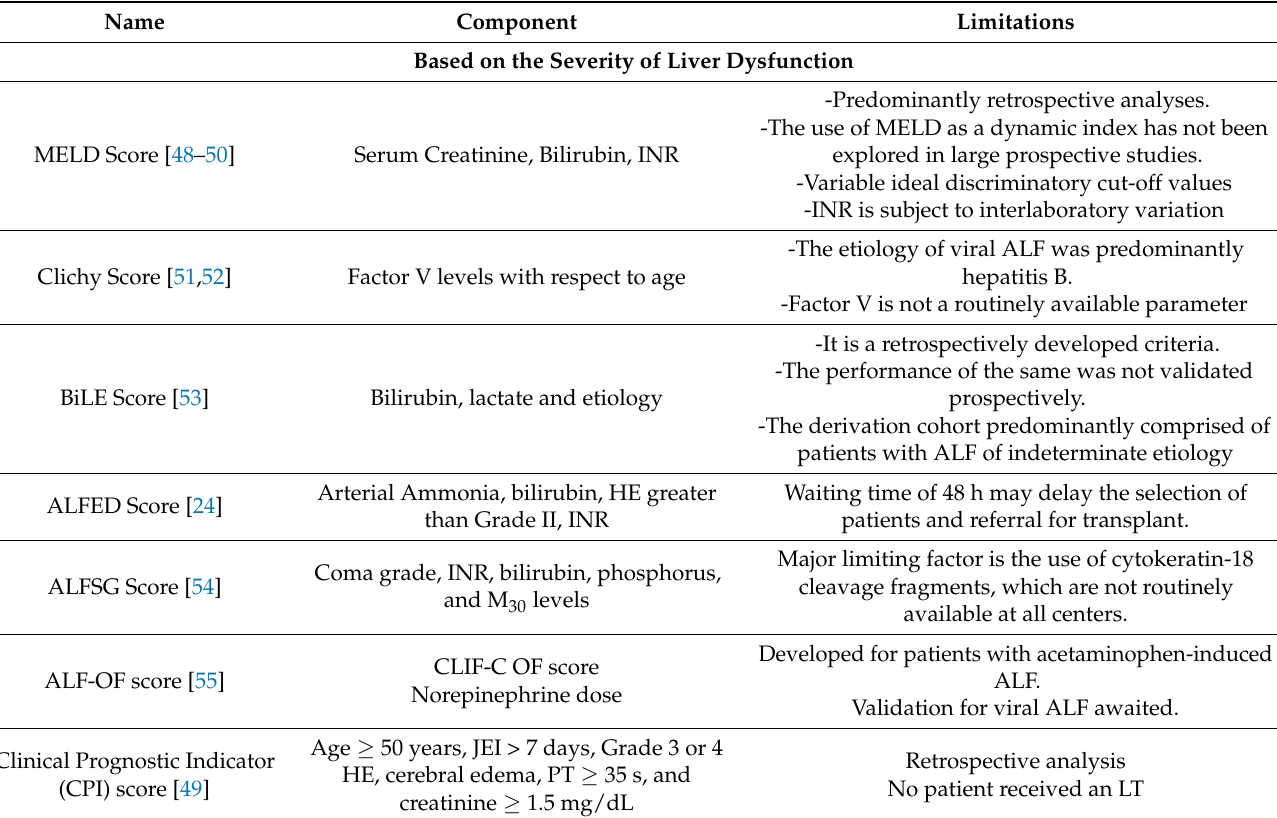
Table 5. Currently available scoring systems with individual components and